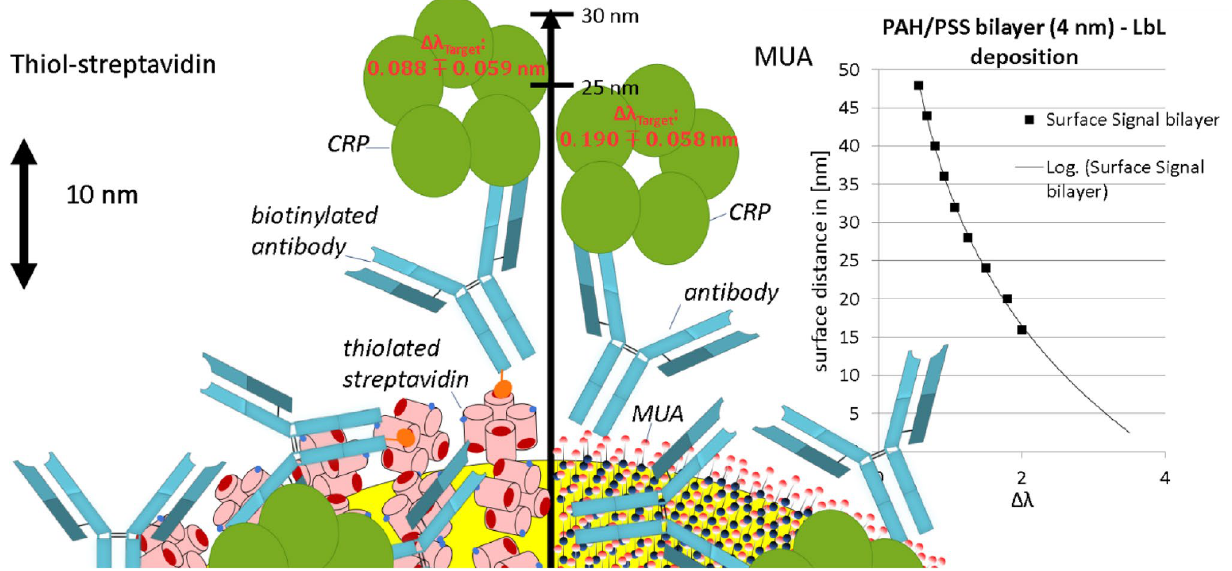
Figure 1. Scheme of the studied immobilization approaches for anti-CRP antibodies. Left: Biotinylated anti- CRP antibodies are attached to the gold surface by thiolated streptavidin. Right: After a surface modification by a self-assembled monolayer of MUA, EDC chemistry is utilized to attach unmodified anti-CRP antibodies. The inset shows the decrease of the sensor signal with increasing surface distance for layer-by-layer (LbL) deposition with charged polyelectrolyte (PEL)